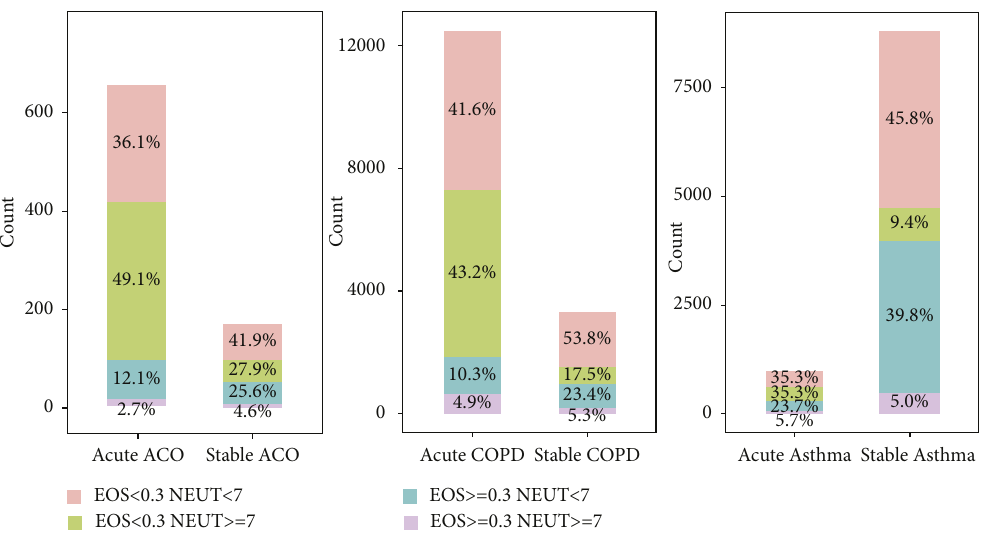
Figure 6: Population distribution of eosinophil and neutrophil levels in acute, or stable groups and their proportions at each level in asthma, COPD or ACO patients. We differentiated acute and stable patients in asthma, COPD, and ACO groups according to eosinophils 0.3 × 10 9 /L and neutrophils 7 × 10 9 /L, respectively. The percentages showed the proportions of patients with different cell levels combinations in the total number of stable or acute patients, where blue and purple presented the percentage of eosinophils greater than or equal to 0.3 × 10 9 /L; red and green presented the percentage of eosinophils less than 0.3 × 10 9 /L; green and purple were the percentage of neutrophil levels greater than or equal to 7 × 10 9 /L; red and blue were the percentage of neutrophil levels less than 7 × 10 9 /L. The column height corresponds to the number of people in each group on the Y axis. (COPD, chronic obstructive pulmonary disease; ACO, asthma-COPD overlap; EOS, eosinophils; NEUT, neutrophils). Table 2: Baseline characteristics of 30 participants from three groups (COPD, chronic obstructive pulmonary disease; ACO, asthma-COPD overlap; SD, standard